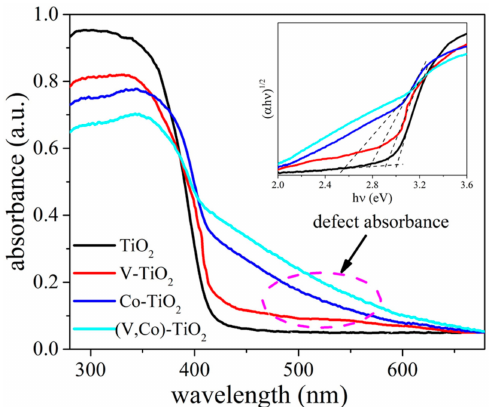
Figure 5. UV-Vis spectra of TiO 2 , V–TiO 2 , Co–TiO 2 , and (V,Co)–TiO 2 samples, inset displays the corresponding Tauc plots, as well as the band gap values.